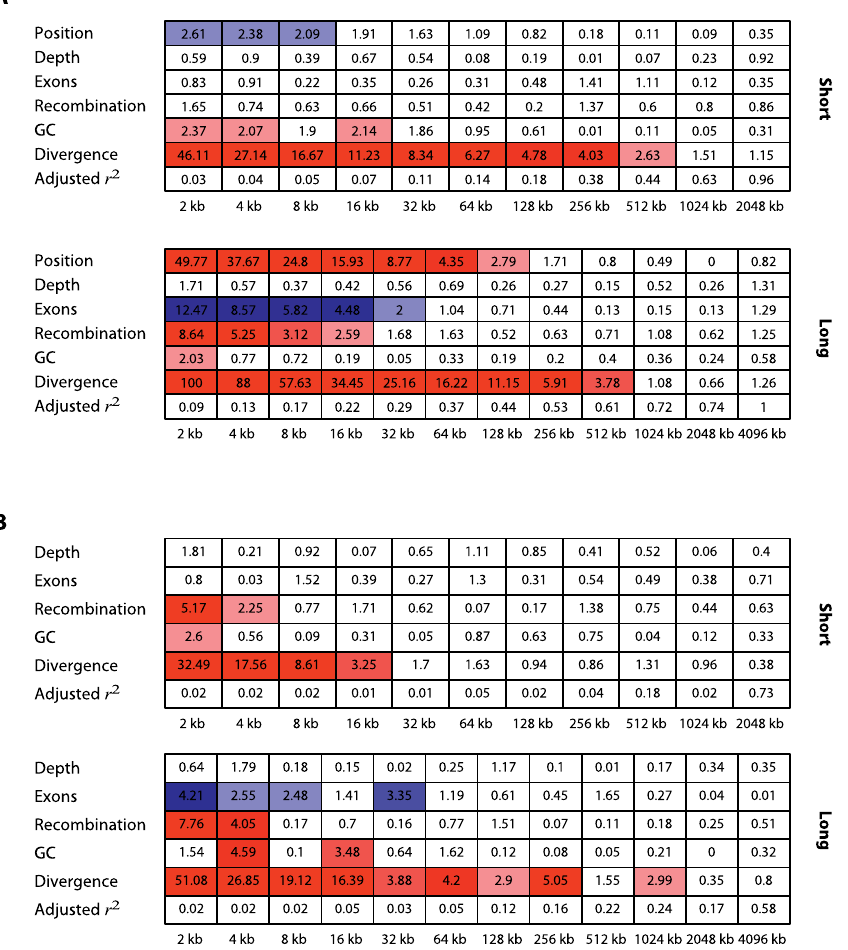
Figure 3. Marginal Significance ( (cid:1) log 10 p-value as Determined by t- Test) of the Wavelet Coefficients from Four Annotations as Predictors of the Coefficients of the Decomposition of Ascertainment Panel Diversity Red boxes highlight significant positive linear relationships and blue negative. The intensity of the colour is proportional to the degree of significance. (A) Smoothed coefficients. (B) Detail coefficients. Also shown is the adjusted r 2 , which can be interpreted as the proportion of the variance in the signal explained by the linear model. DOI: 10.1371/journal.pgen.0020148.g003